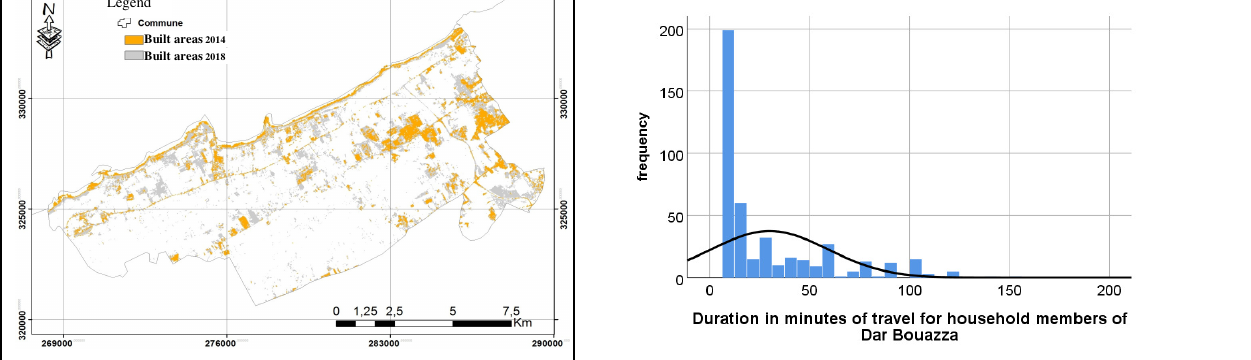
Figure 3: Comparison of the built-up areas at Dar Bouazza between 2014 and 2018